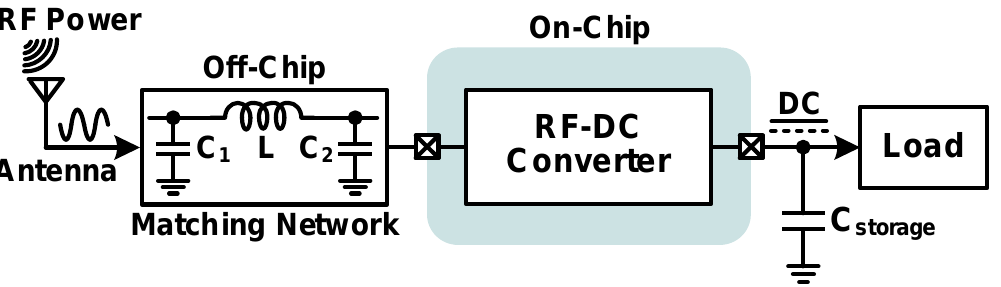
Figure 1. Block diagram of an Radio Frequency (RF) energy harvesting system.